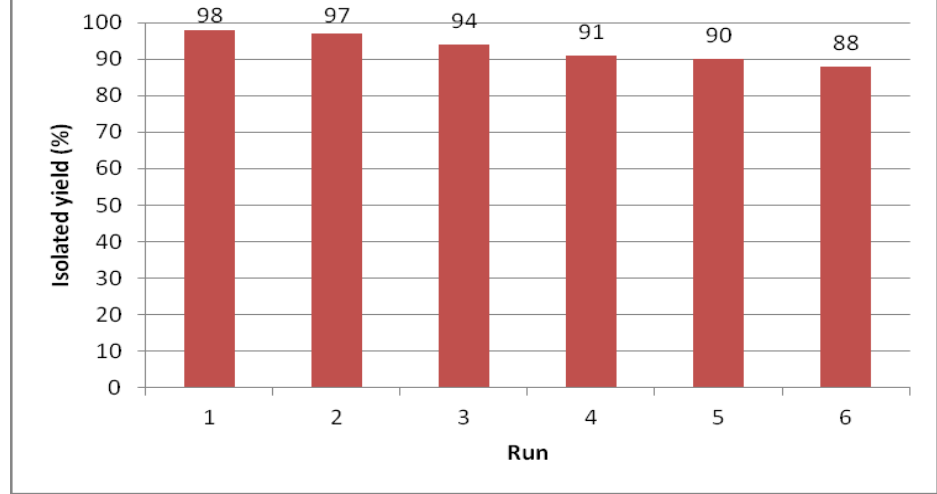
Fig. 8. Recycling of CuFe